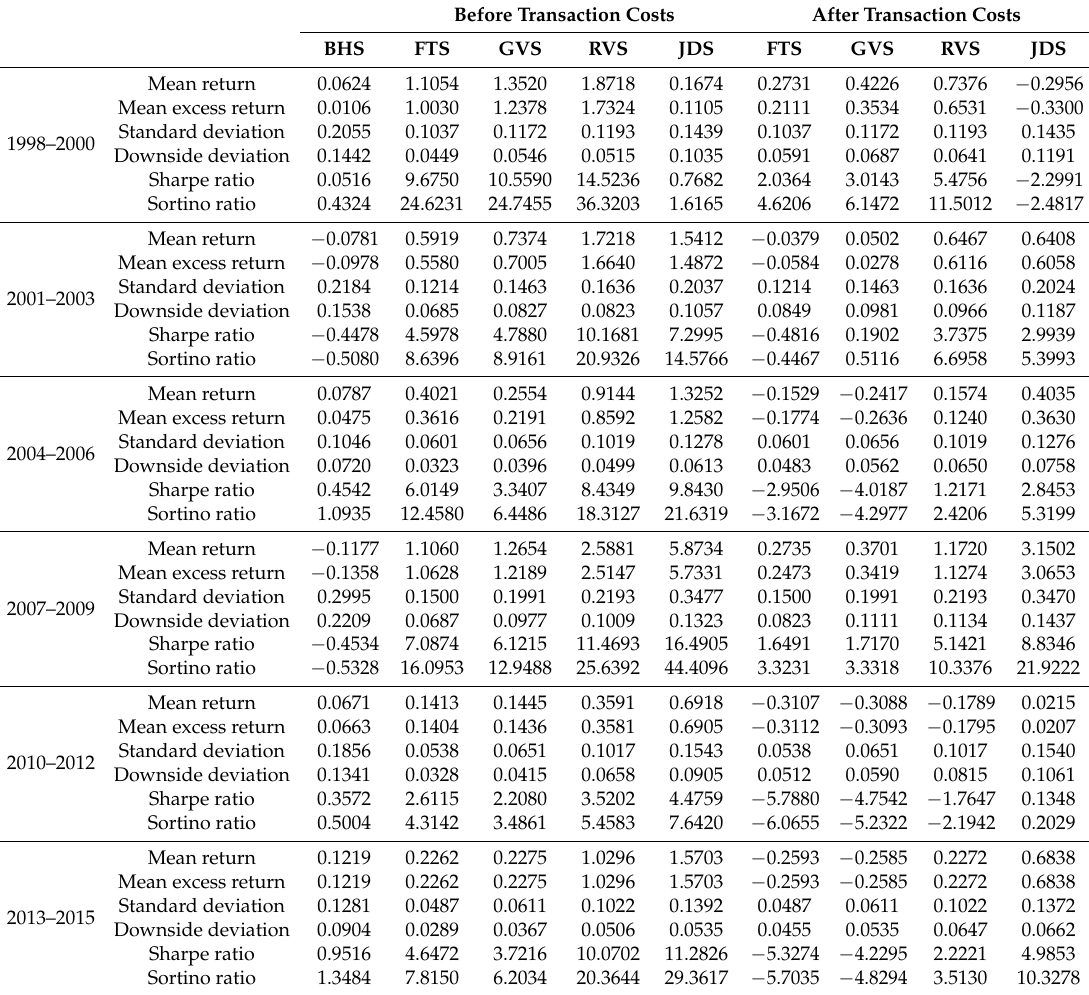
Table A2. Annualized risk-return measures for BHS, FTS, GVS, RVS, and JDS for sub-periods of 3 years from January 1998–December